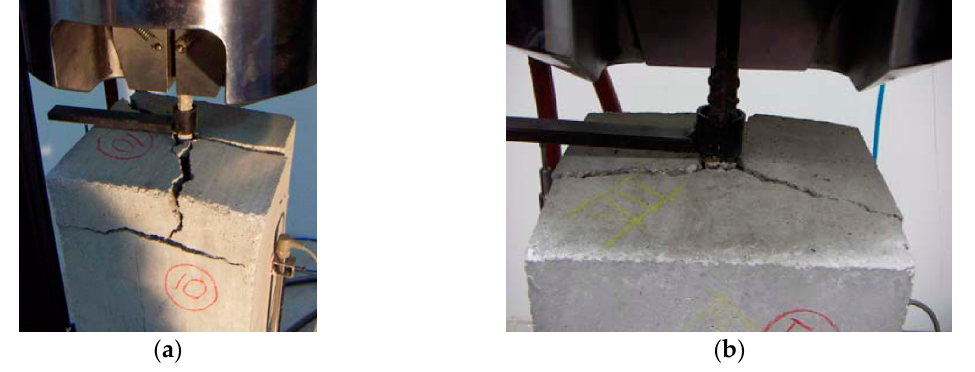
Figure 8. Concrete tensile failure: ( a ) specimen S10; ( b ) specimen S52.